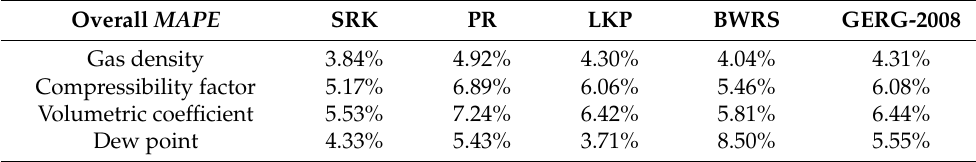
Table 11. Summary of the precisions of the five physical property calculation